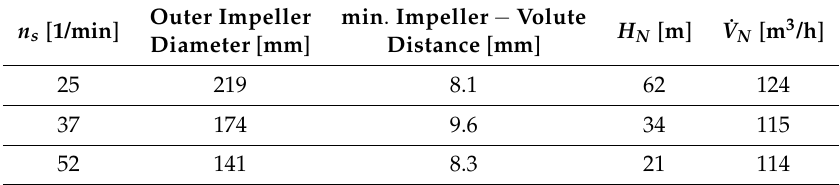
Table 2. Specifications of the investigated